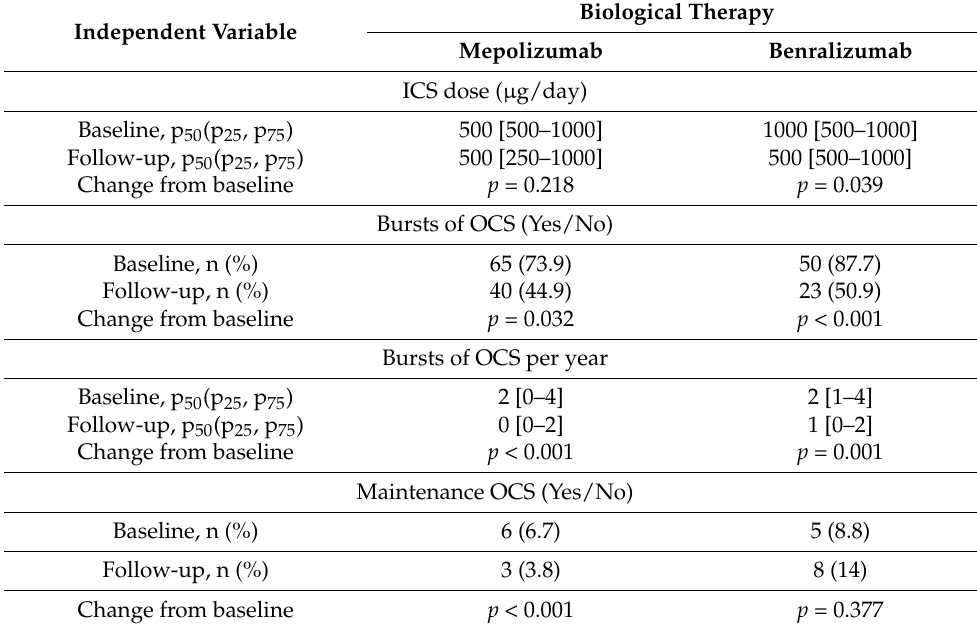
Table 3. Changes in baseline variables after 12 months of biological